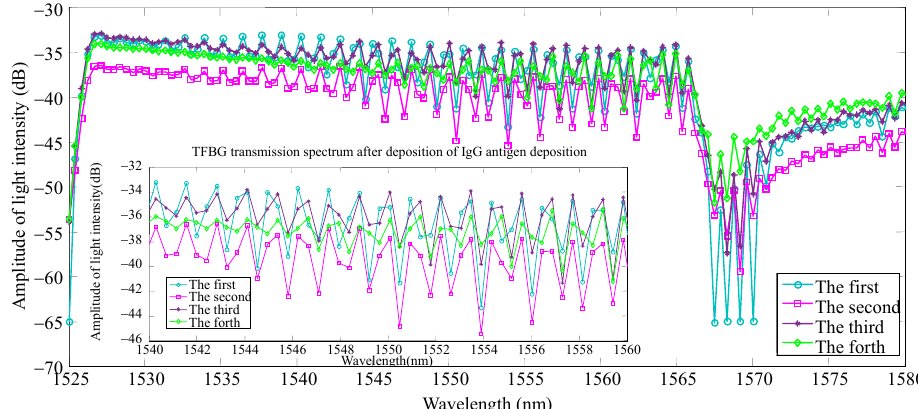
Fig. 7 TFBG transmission spectrum after IgG antigen deposition